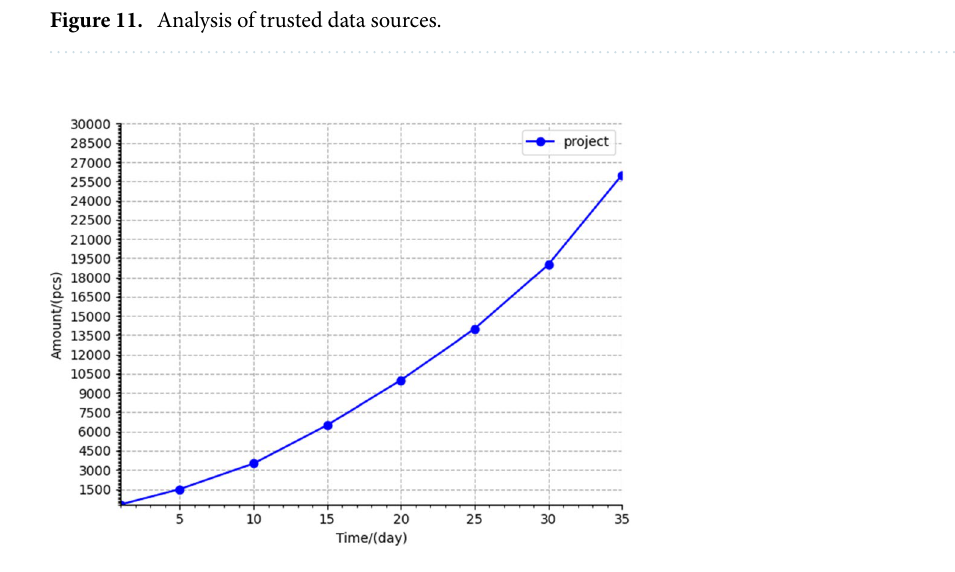
Figure 12. Business processing capability analysis of the prototype